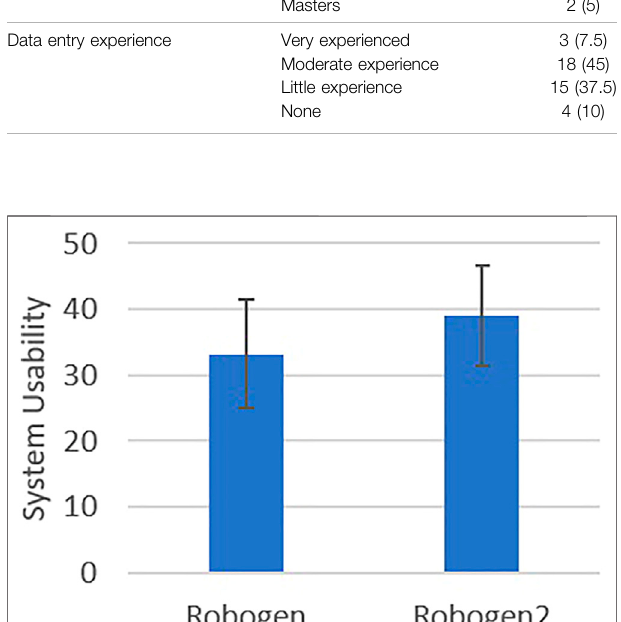
FIGURE 4 | System usability of RoboGen versus RoboGen2.